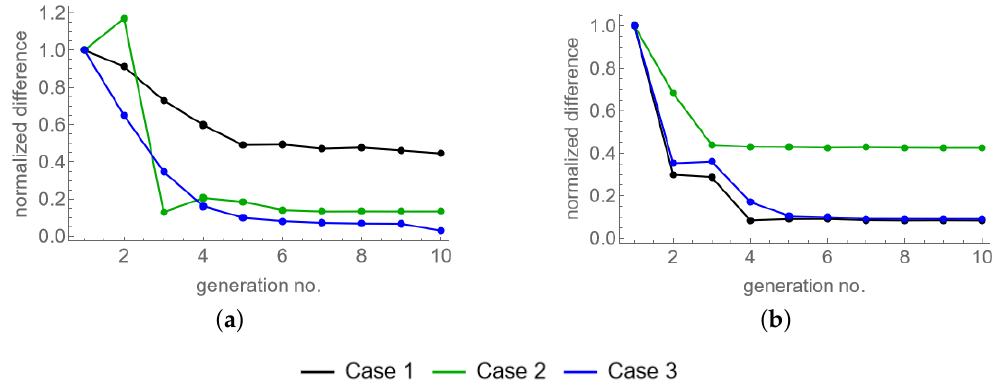
Figure 4. Plot of the normalized difference vs. generation in each of the EA runs stating from Population 1 ( a ) and Population 2 ( b ).